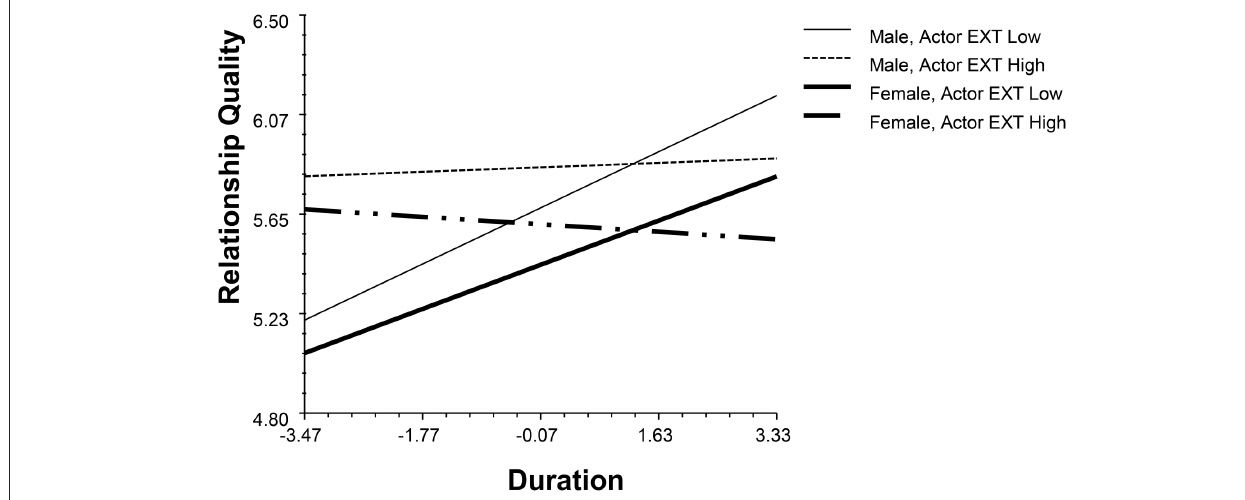
FIGURE 1 | The interaction between actor’s extraversion, gender and duration.